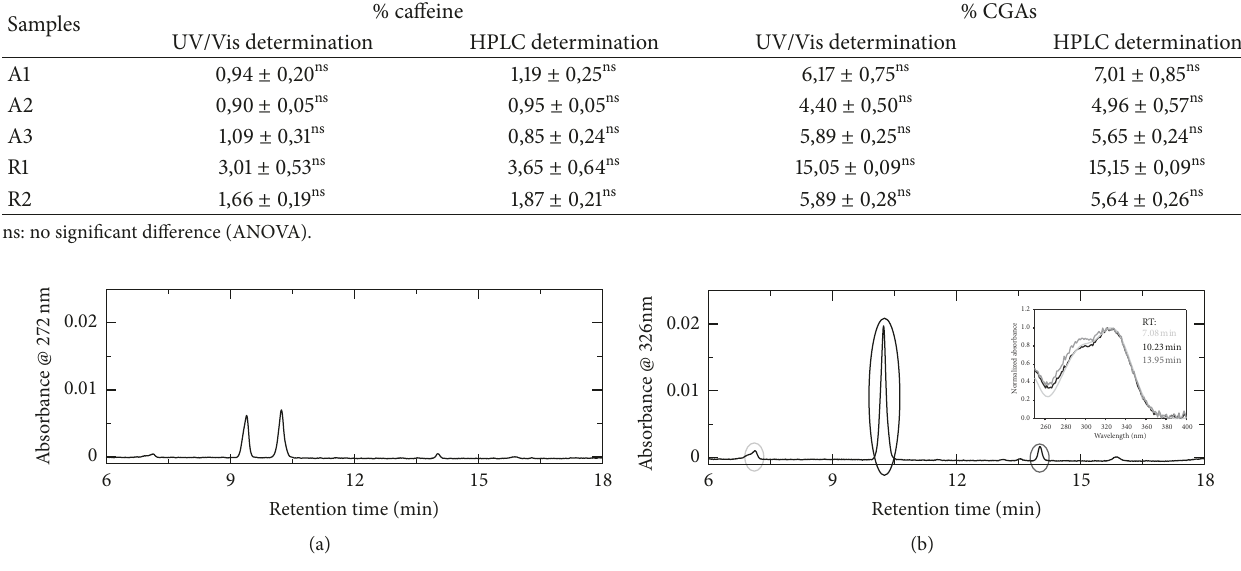
Figure 6: Chromatographic profiles registered at the maximum of absorbance for caffeine (a) and CGAs (b) as function of the retention time. The inset in (b) shows the normalized spectra for species evidenced in the